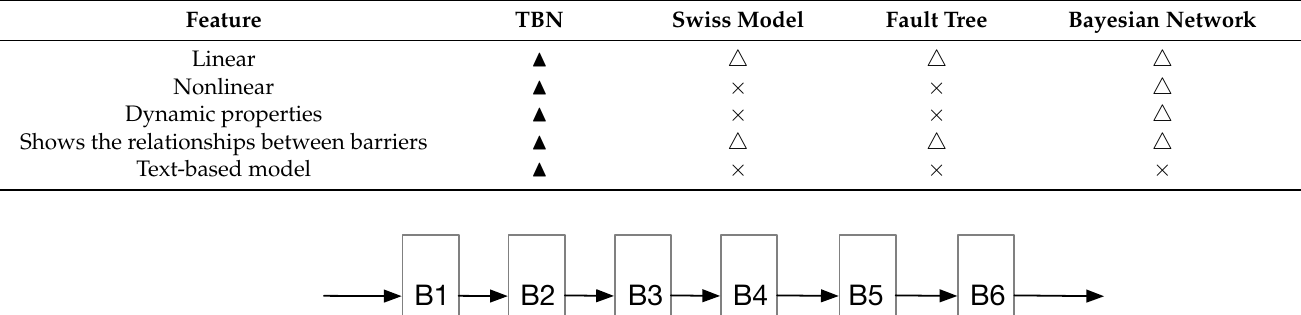
Table 2. Summary of the comparison of text-based Bayesian network (TBN) with other methods. Feature